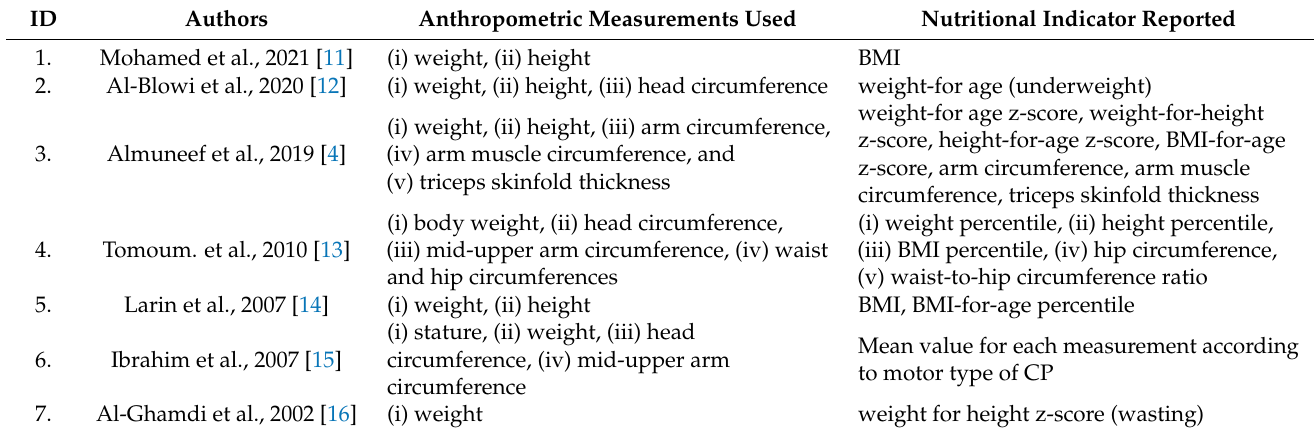
Table 4. Anthropometric measurements